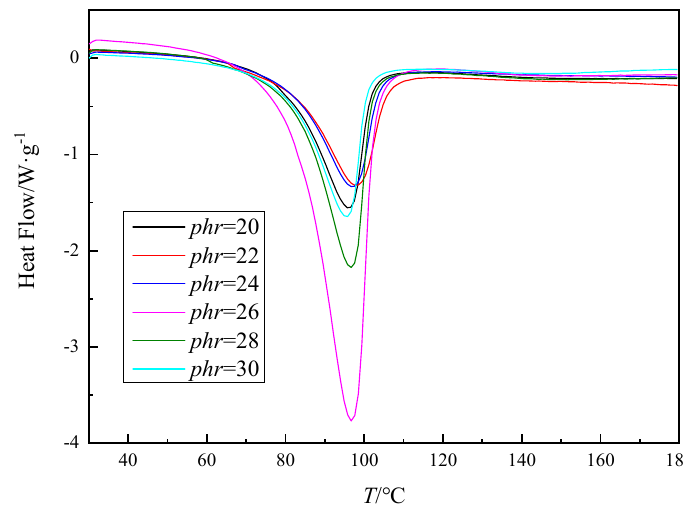
Figure 1. The differential scanning calorimetry (DSC) curves for N,N,N ′ ,N ′ -tetraepoxypropyl-4,4 ′ - diaminodiphenylmethane epoxy resin (AG-80)/m-xylylenediamine (m-XDA) curing system with different mass ratios ( phr = 20, 22, 24, 26, 28, 30) at a rate of 2.5 K/min . Table 1. The exothermic values for AG-80/m-XDA curing system with different mass ratios ( phr = 20, 22, 24, 26, 28, 30) at a rate of 2.5 K/min .